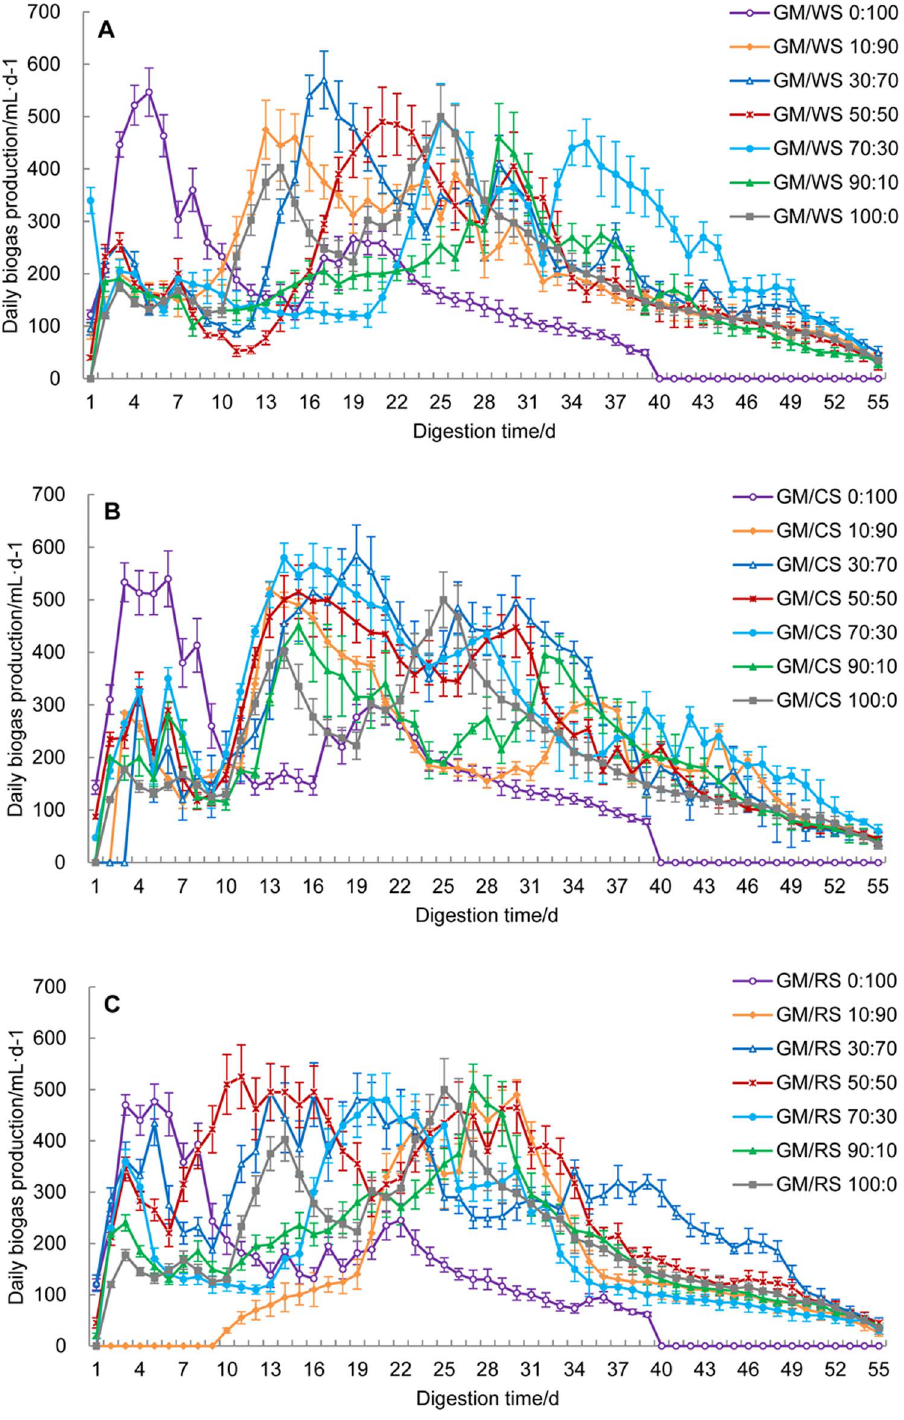
Figure 1. Daily biogas production from the co-digestion of GM and WS (A), CS (B) and RS (C) with different mixing ratios. Mean values originated from three independent replications. Vertical bars represent standard deviations. doi:10.1371/journal.pone.0066845.g001 microbial growth and methanogenesis because of the ammonium